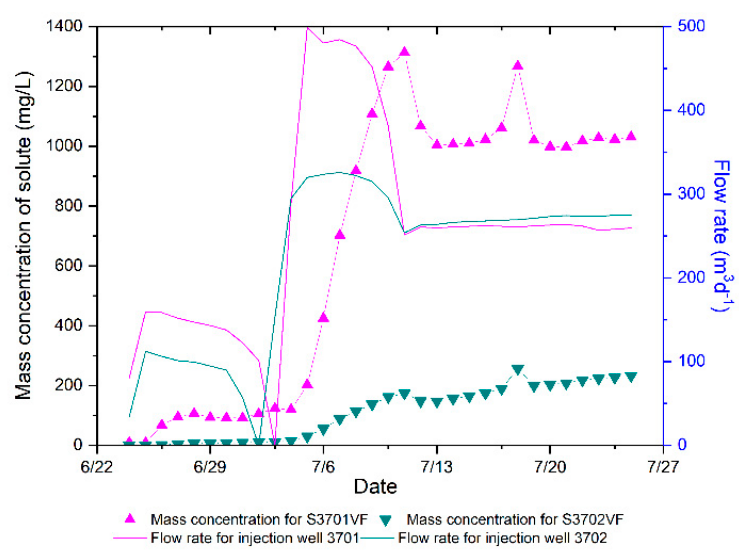
Figure 12. Injection flow and corresponding solute concentration. The concentrations of solutes S3301 and S3302 showed a continuous upward